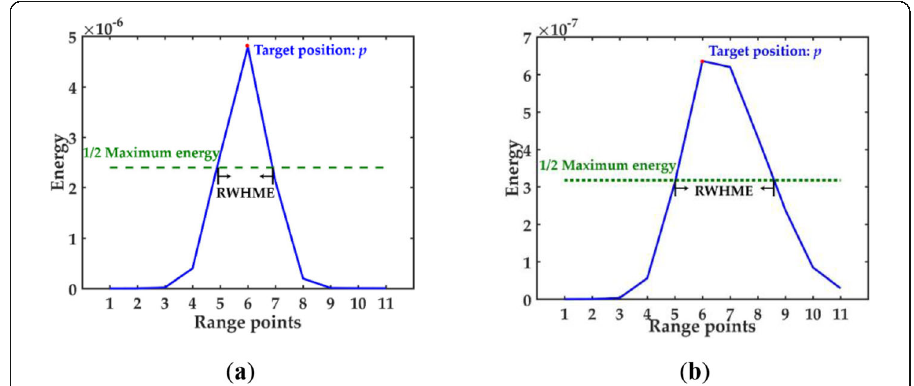
Fig. 8 Comparison of energy changes in the fixed range window between human and dog target. a Energy changes of human target. b Energy changes of dog